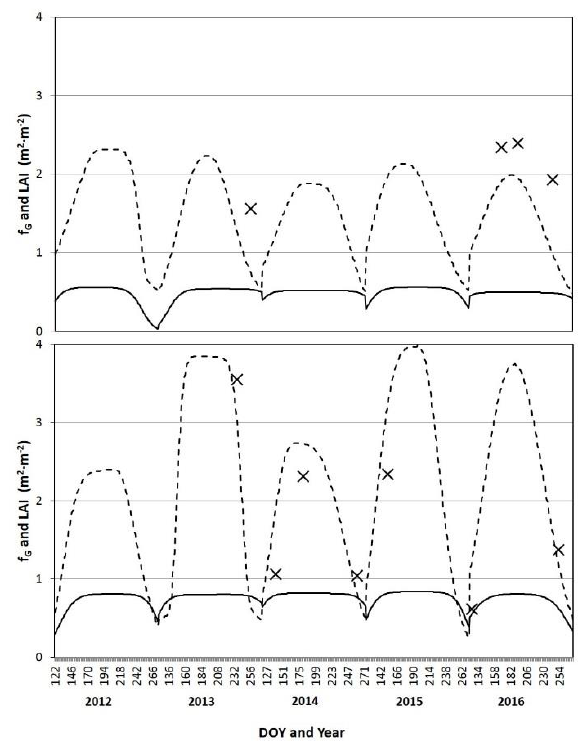
Figure 3. Seasonal behavior of LAI (dashed line) and f G (solid line) from 2012 to 2016 for the study period (May to September) at black spruce (UAF, top panel ), and birch (CPCRW, bottom panel ) flux towers. Black crosses are the LAI in-situ estimates.